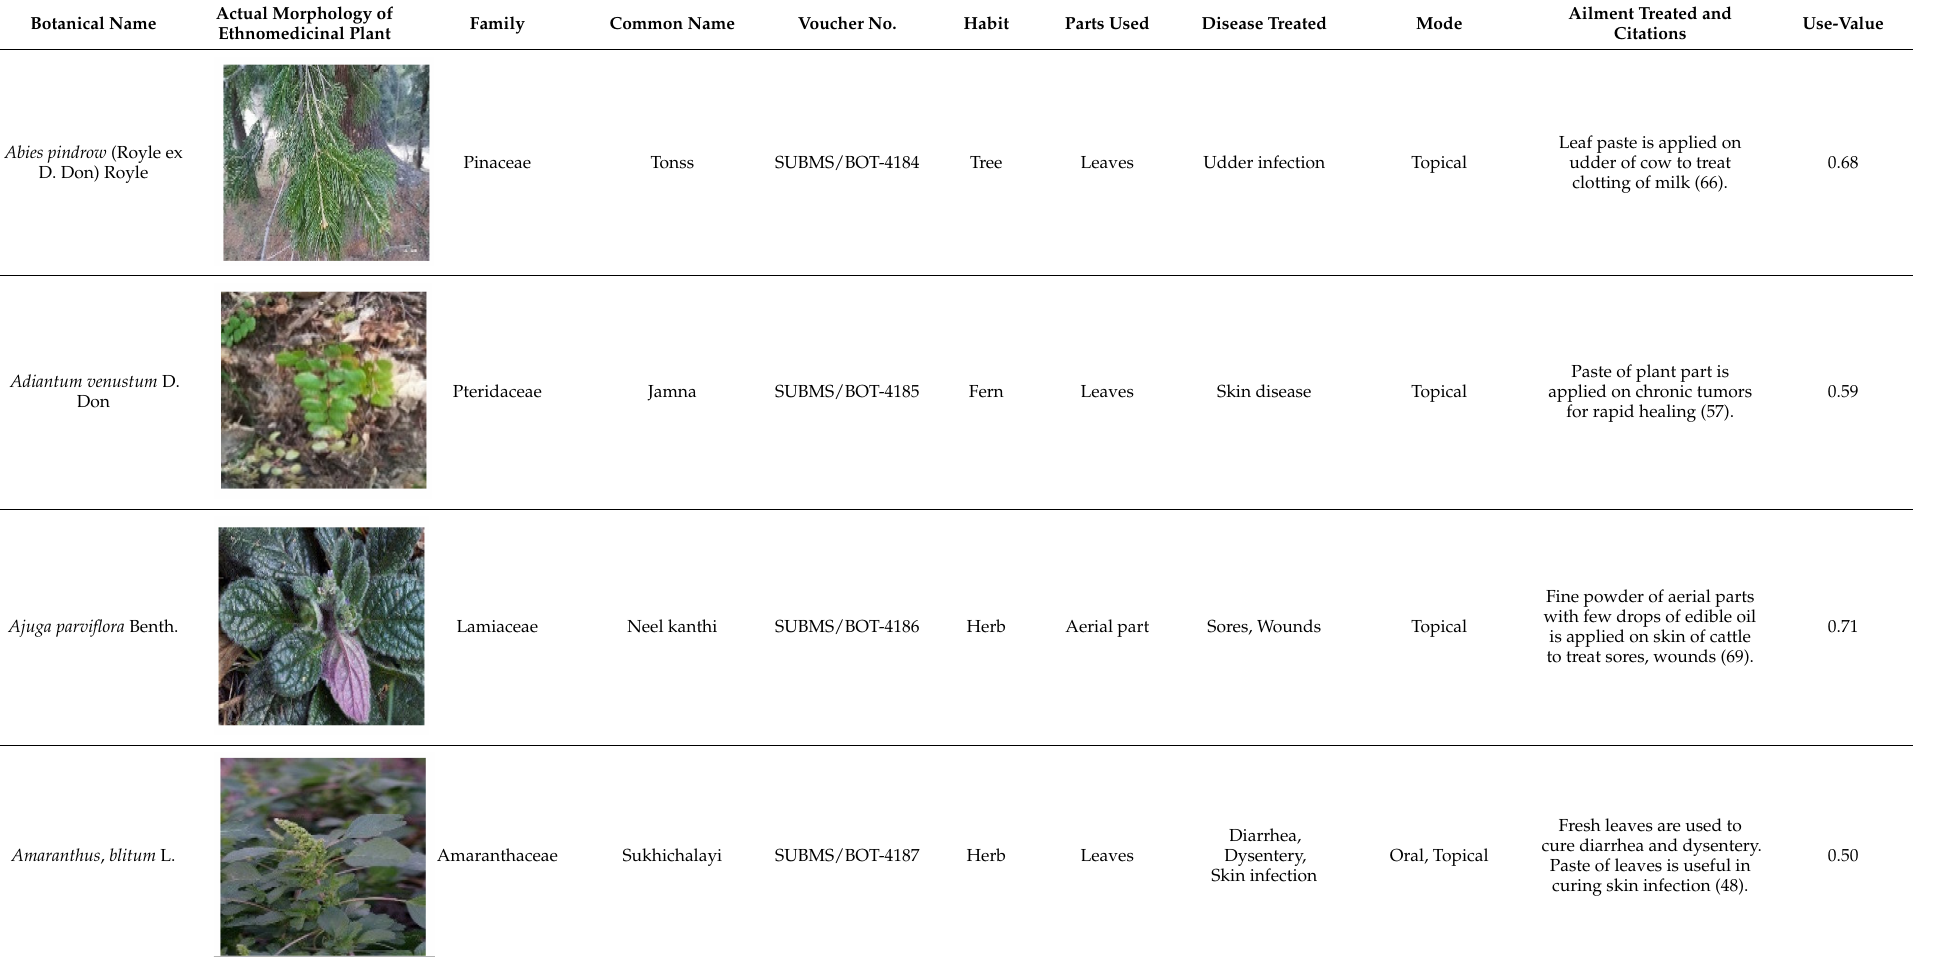
Table 2. Ethnomedicinal plants used in study